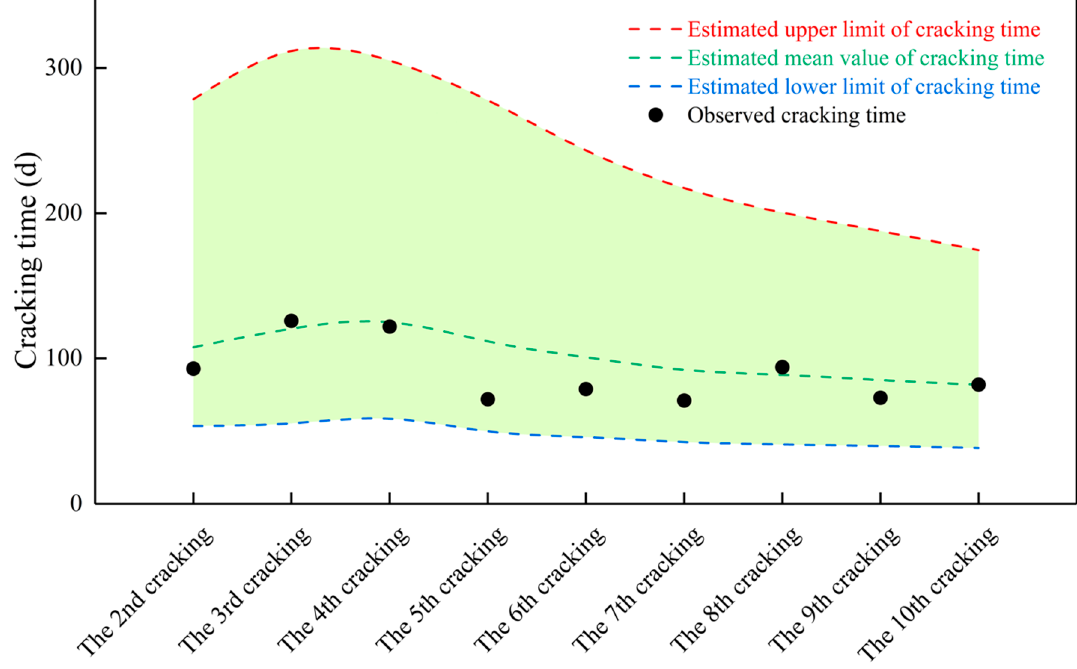
Figure 15. The estimated mean values and upper and lower limits of cracking times for the actual cracking events.